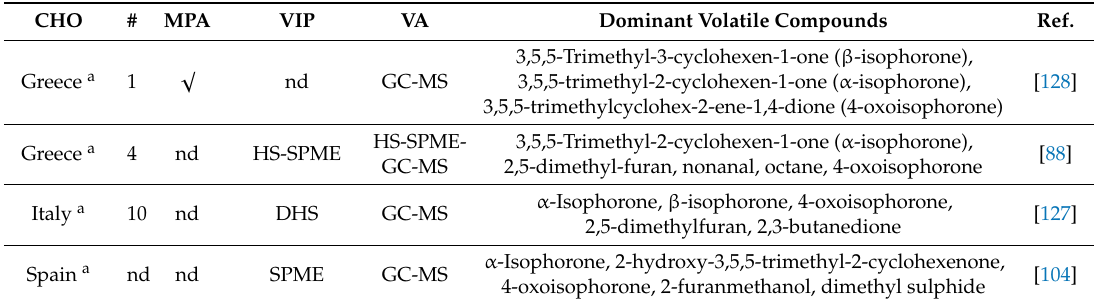
Table 19. Strawberry tree honey’s main volatiles, with reference to the country of origin, number of samples, isolation and analysis procedures and five main volatile components. Unless otherwise specified, the honeybee type was A. mellifera .